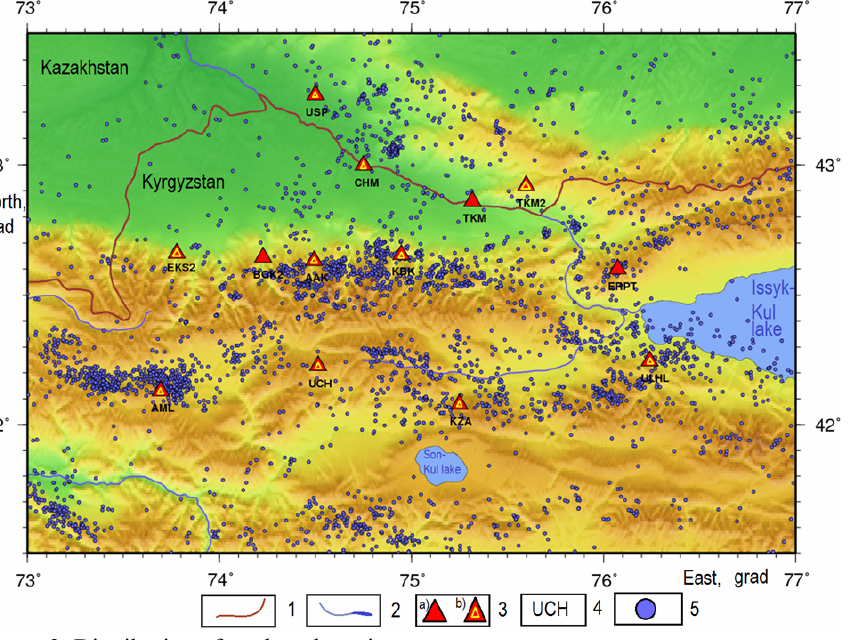
Figure 3. Distribution of earthquake epicenters: 1 – state border of the Kyrgyz Republic; 2 – rivers; 3 – KNET seismic network: a) all seismic stations as of 2000, b) actual working seismic stations as of 2021; 4 – earthquake